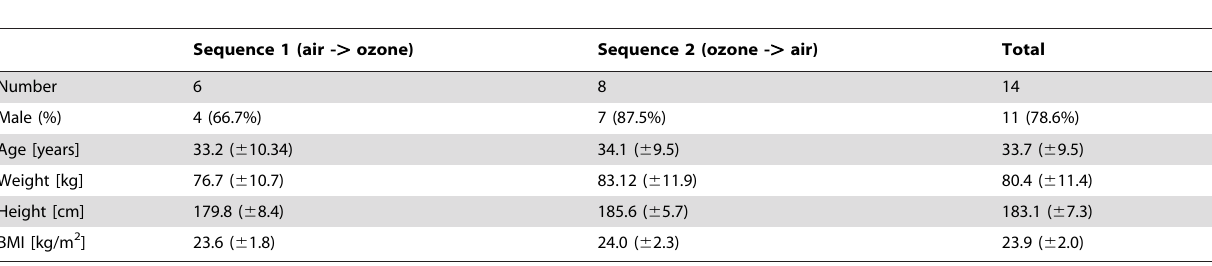
Table 1. Characteristics of the study population.